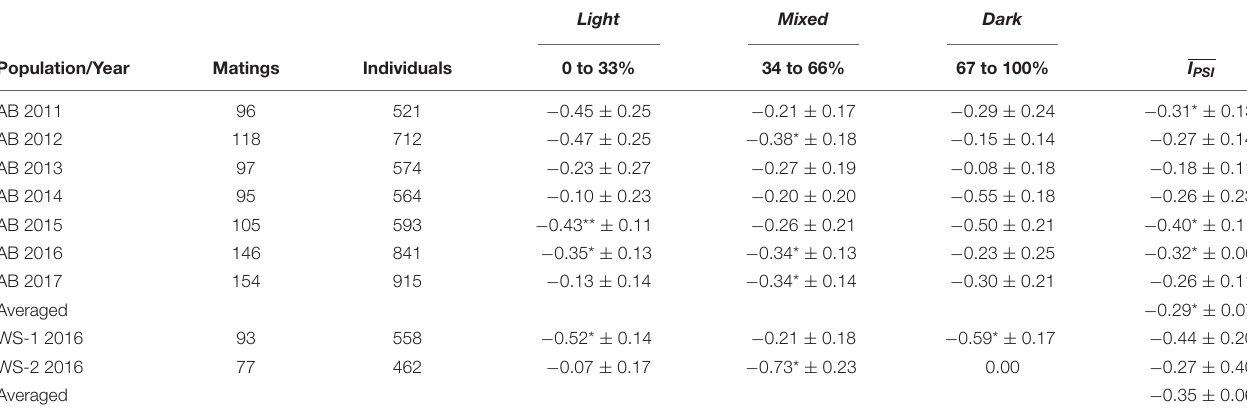
TABLE 1 | Assortative mating ( I PSI ) estimates (mean ± sd ) of shell color for L. fabalis in seven consecutive years in Abelleira (AB) and in two subpopulations of the White Sea (WS-1, WS-2) in 2015. Light Mixed Dark Population/Year Matings